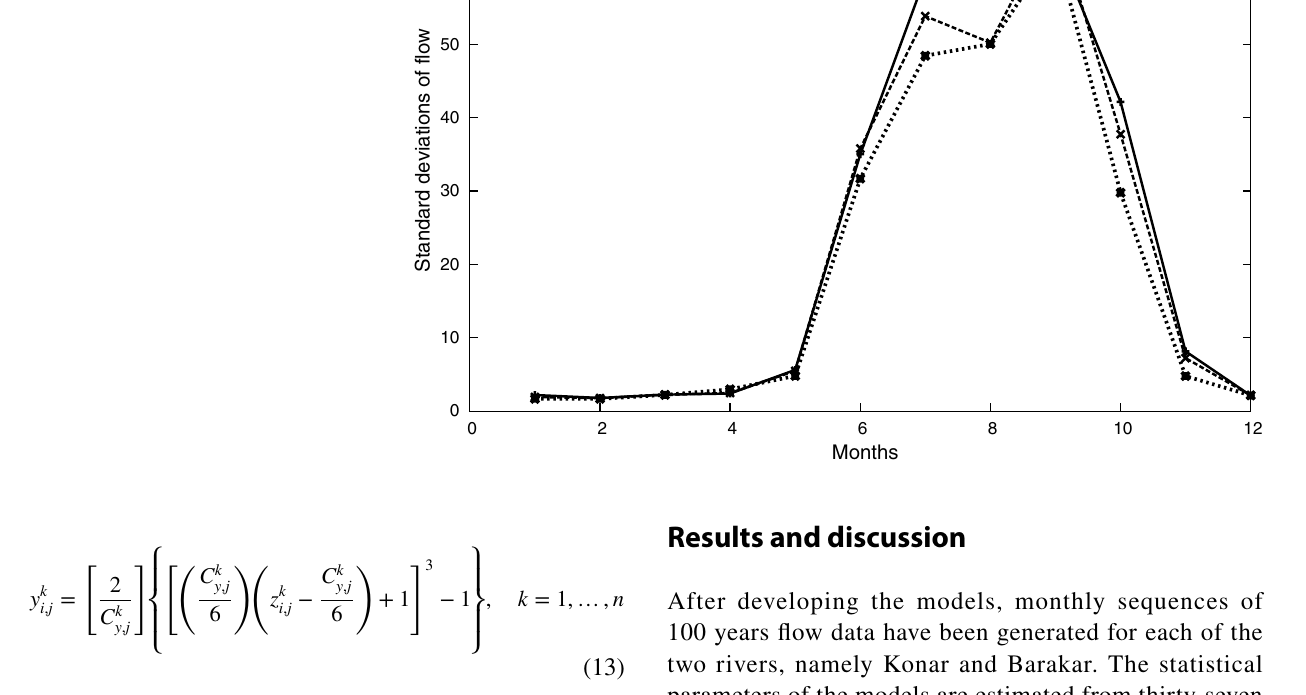
Fig. 12 Historical and generated monthly standard deviations of flows in Konar River (multi-site